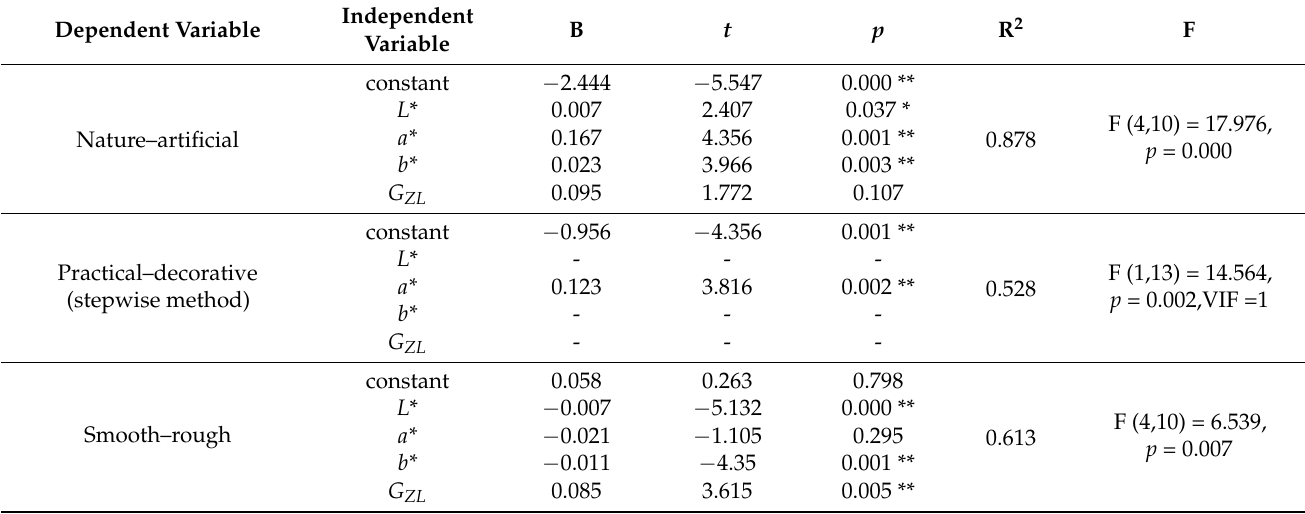
Table 9. Ridge and stepwise regression analysis results between comprehensive physical and psycho- logical